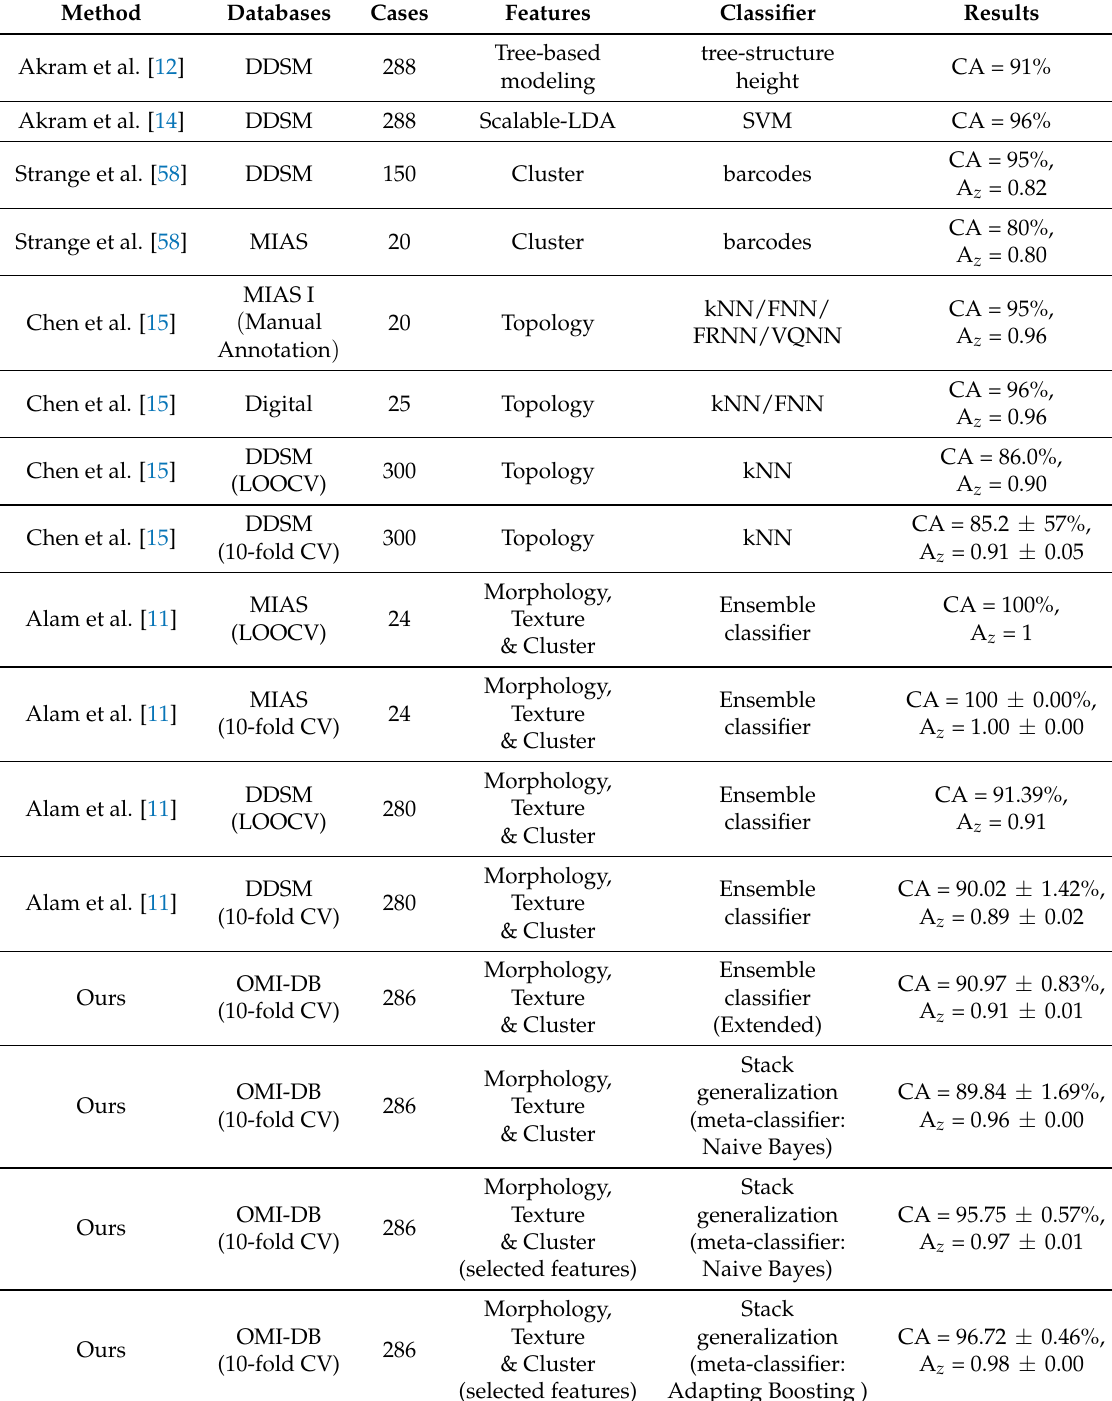
Table 7. A qualitative comparison of our results with respect to related